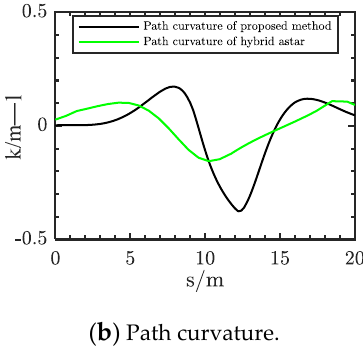
Figure 7. Planned result in scenario 1.